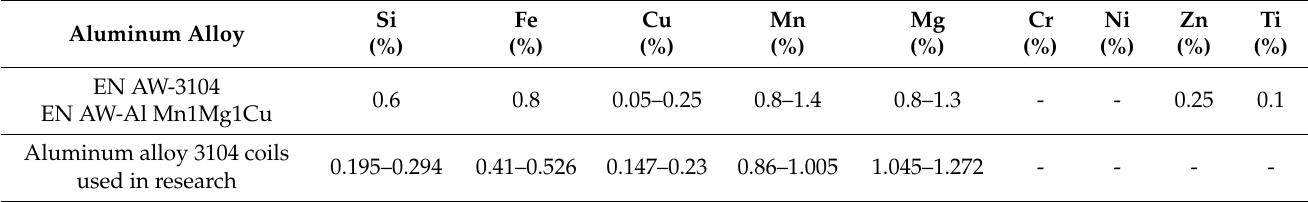
Table 2. Chemical composition of aluminum alloy 3104 and for tested